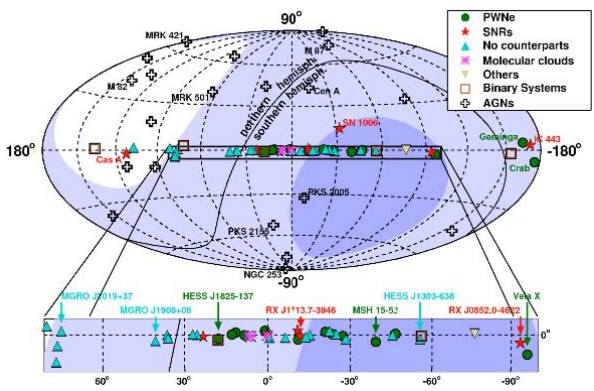
Fig. 1. Sky coverage in Galactic coordinates for detectors located in the Mediterranean Sea and at the South Pole, where only the Northern Hemisphere can be observed. The shading indicates the visibility for a detector in the Mediterranean with 2 π downward coverage; dark (light) blue areas are visible at least 75% (25%) of the time. The locations of observed sources of high-energy γ rays are also indicated.